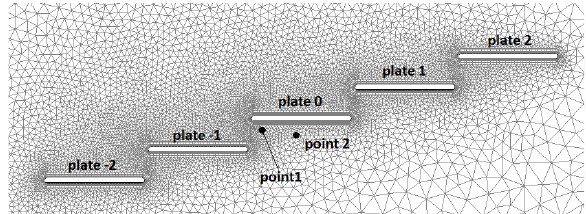
Fig. 6. PIV measured steady velocity field